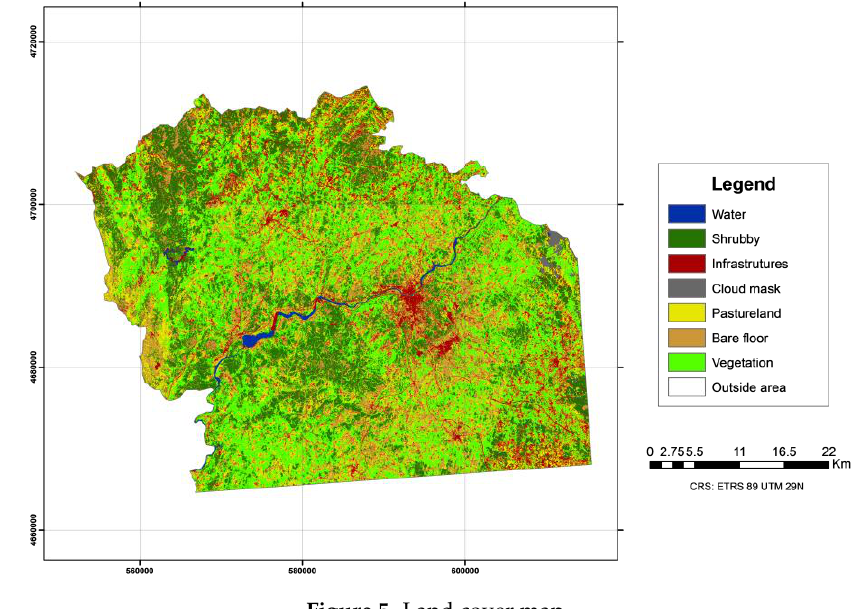
Figure 5. Land cover map.